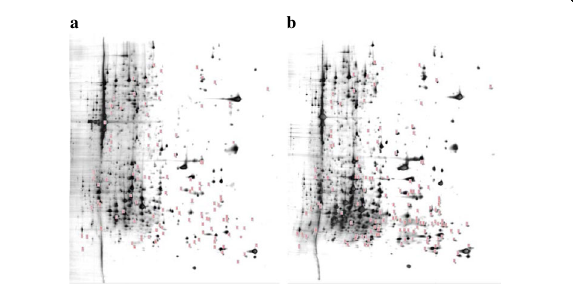
Fig. 11 2-D isoelectric focusing results for the oridonin and control groups. a control group (EM); b drug group